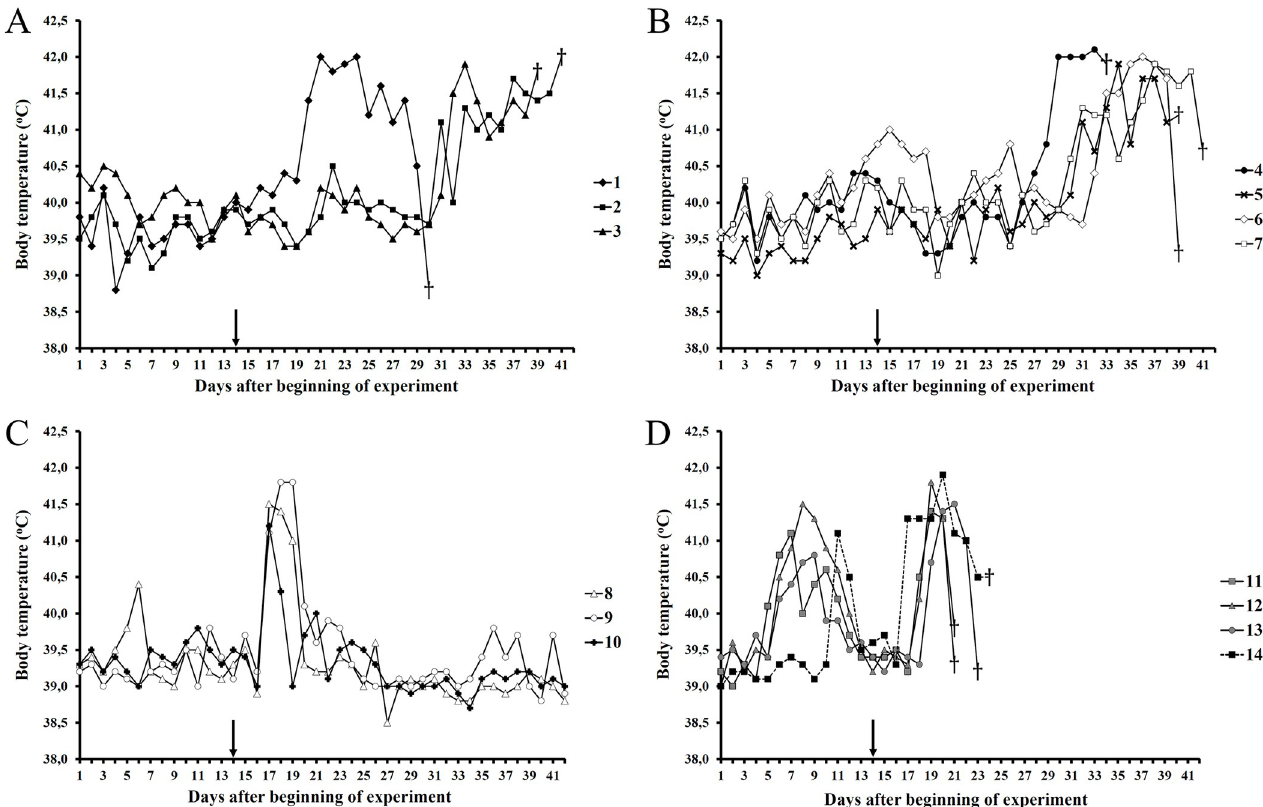
Fig 1. The kinetics of body temperature values of pigs inoculated with attenuated ASFV strain KK-202 (107.5 HAU50) and/or vaccine strain FK-32/135 (107.0 HAU50) and subsequently challenged with the virulent ASFV strain France-32 (107.0 HAU50) on day 14. A. (1–3) KK-202 + FK-32/135 (at an interval of 2 days); B. (4–7) KK-202 + FK-32/135 (simultaneously); C. (8–10) FK-32/135; D. (11–13) KK-202 and (14) na ï ve (control). Each curve represents the values of individual animals in the groups.